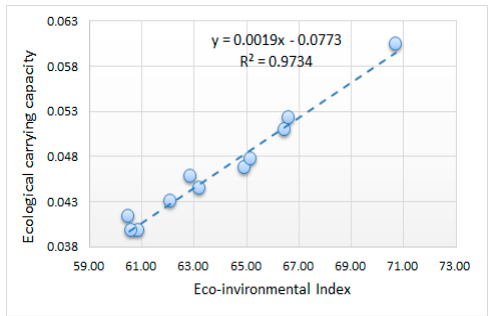
Figure 9. The correlation coefficients of the EI and ecological carrying capacity.